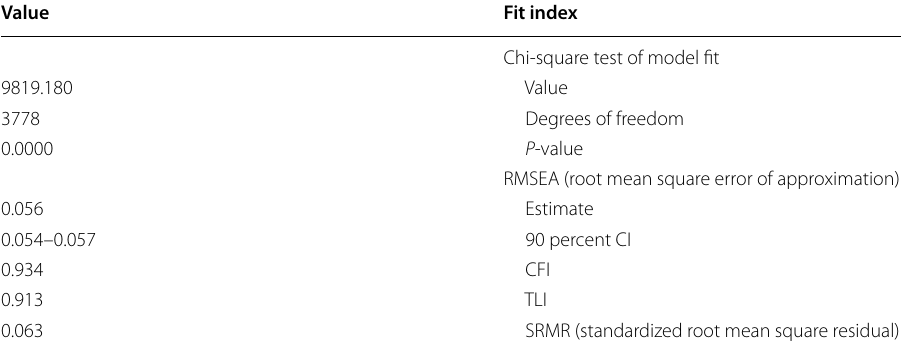
Table 3 Open innovation model fit for the first-order model Value